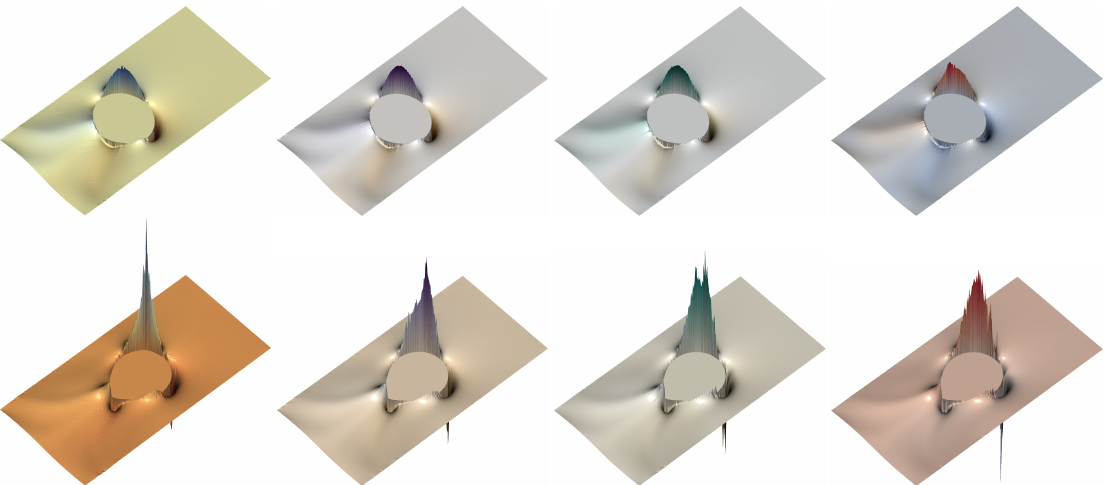
Figure 10. Representation of the shear component of the polymer stress tensor, τ p ,12 , for the Hookean dumbbell model (Oldroyd-B) with c = 5, De = 3, at dimensionless instants of time t = 2 and t = 3, for variable types of CSRBF. From left to right: ϕ 3,0 , ϕ 3,1 , ϕ 3,2 , ϕ 3,3 . Top row: t = 2; bottom row: t =